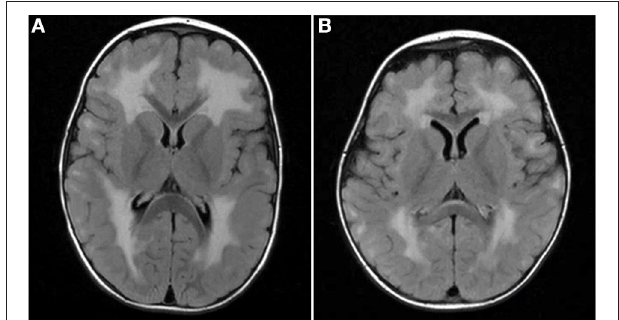
FIGURE 1 | MRI findings in MDC1A-patients included in the study. Brain MRI TIRM (Turbo-Inversion Recovery-Magnitude, axial) show diffuse symmetrical white matter lesions predominantly in the periventricular regions and no involvement of thalamus or brainstem in both cases. (A) Patient 3 with expanded supratentorial leukencephalopathy at two years of age. (B) Patient 4 diffuse